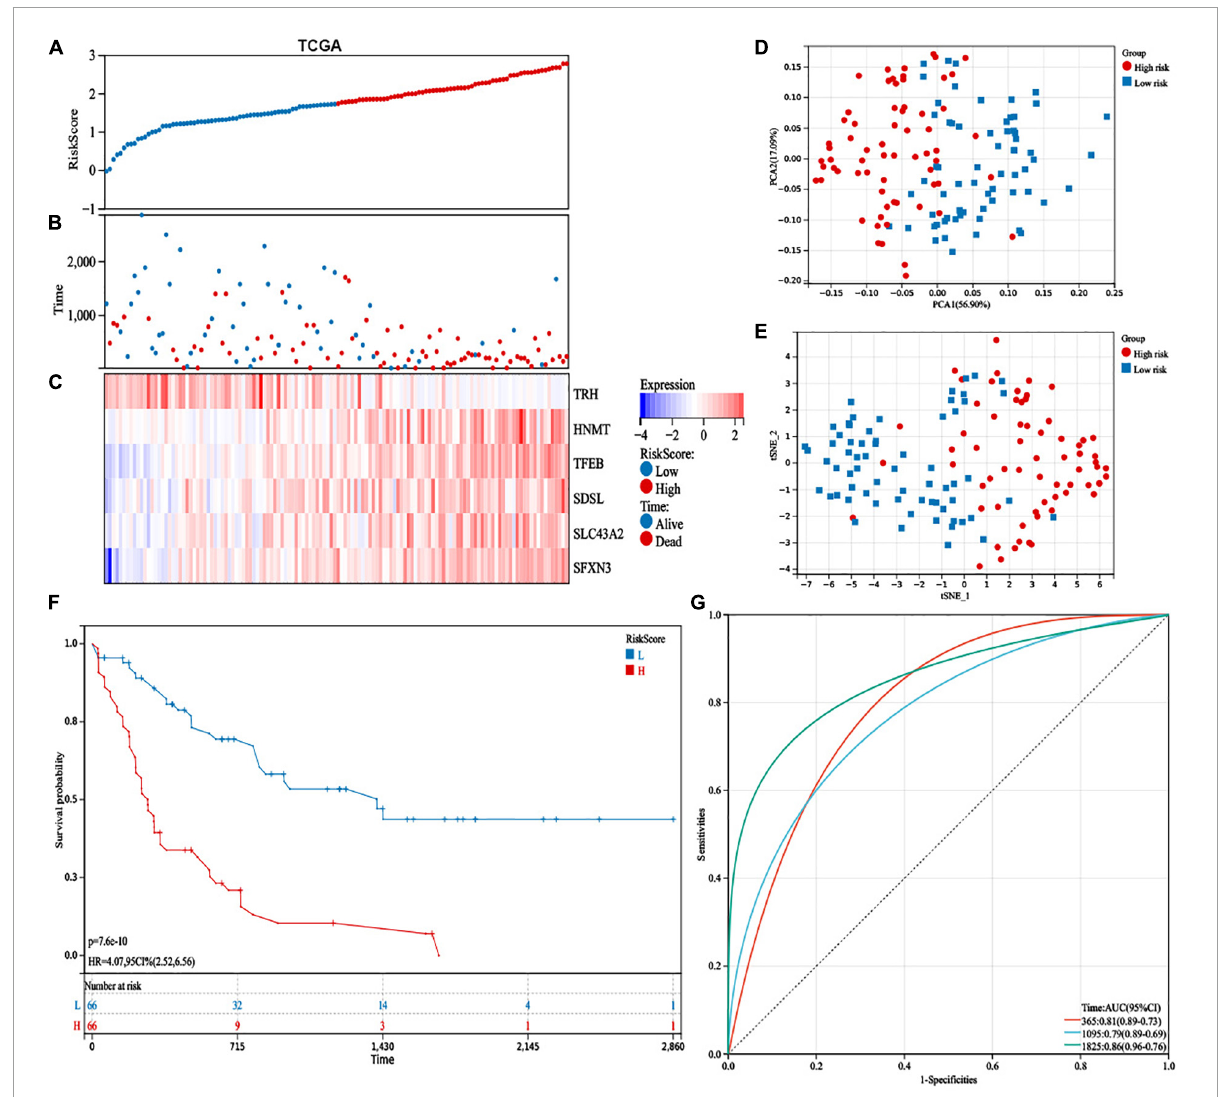
FIGURE4 Prognostic study of the cancer genome atlas (TCGA) database in the 6-gene risk model. (A) Risk scores, (B) survival status, and (C) heatmap of the 6 survival-related amino acid metabolism differentially expressed genes (DEGs). (D) Principal component analysis (PCA) and (E) t-distributed stochastic neighbor embedding (t-SNE) analysis of the six amino acid metabolism-related genes exhibited the differential distribution. (F) Kaplan–Meier analysis of OS between the two groups. (G) The predictive capability with area under curve (AUCs) at 1-, 3-, and